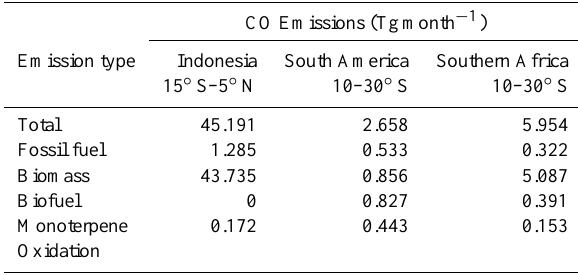
Table 1. CH 4 emissions used for 2006 GEOS-Chem model esti- mates for October 2006.